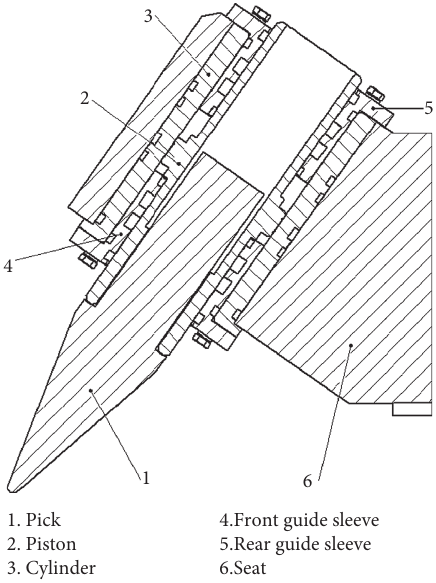
Figure 2: Structure of pick using impacting-cutting technique.